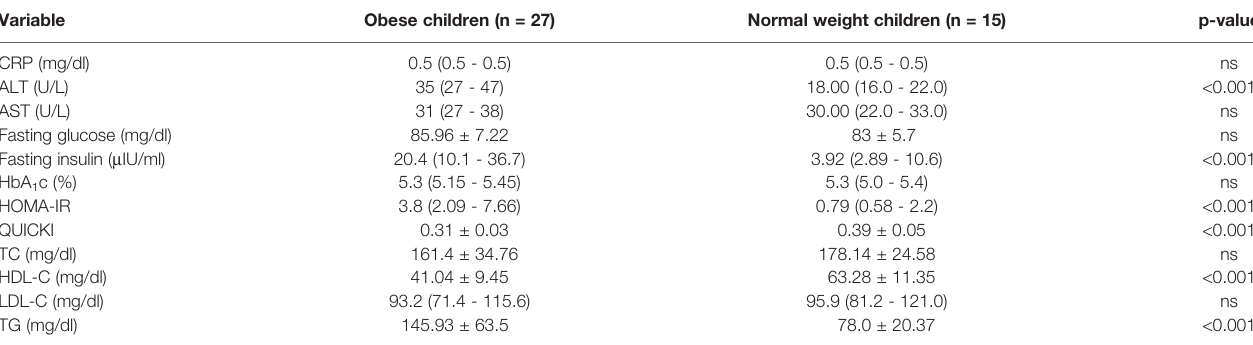
TABLE 2 | Biochemical parameters in overweight and obese children in comparison to normal weight children. Variable